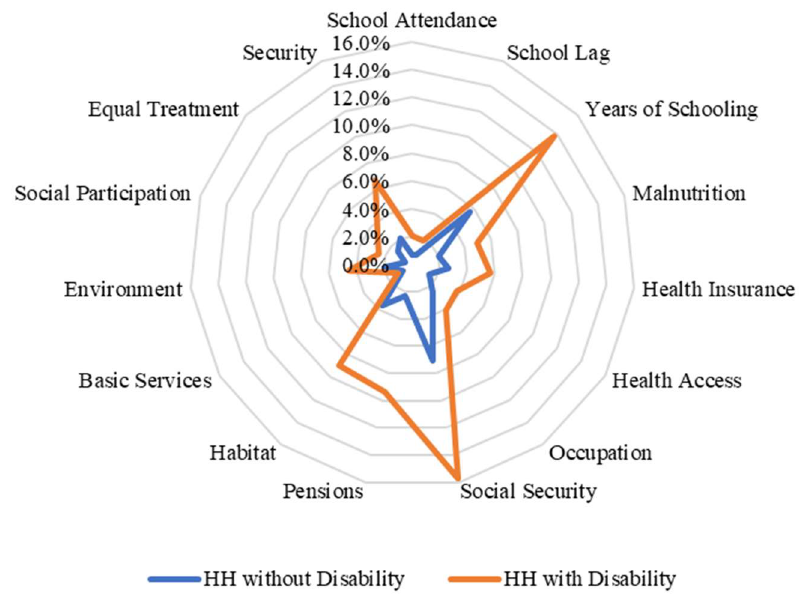
Figure 3. Censored headcount ratios for households with and without members with disability in the highest quintile in Chile.